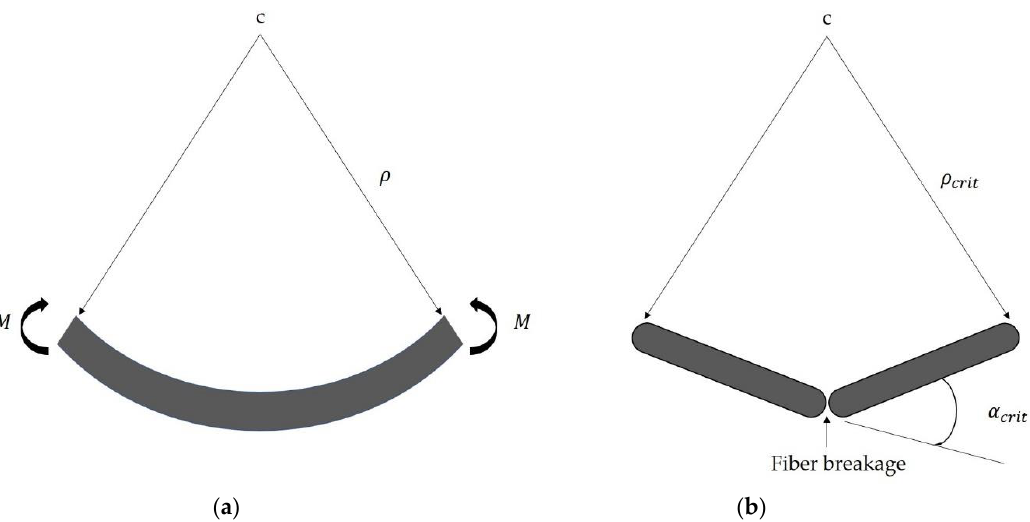
Figure 2. Fiber deformation and approximation with bending theory: ( a ) Beam deformation with pure bending; ( b ) Approximation with rods and the expression of critical curvature during fiber breakage.